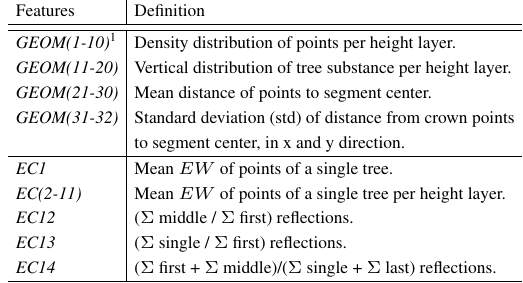
Table 1. 32 GEOM and 14 EC features.